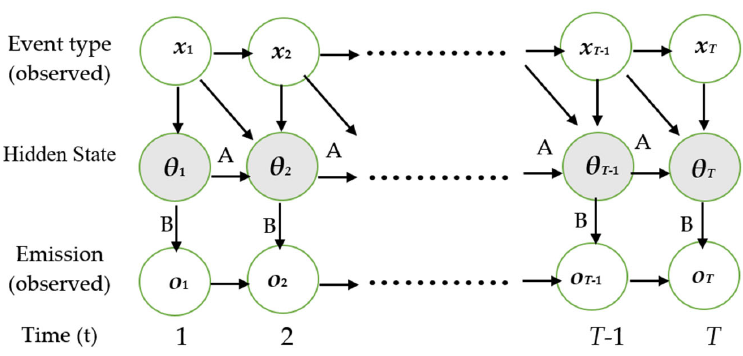
Figure 3. Structure of partially observable hidden Markov model, redrawn from [13].